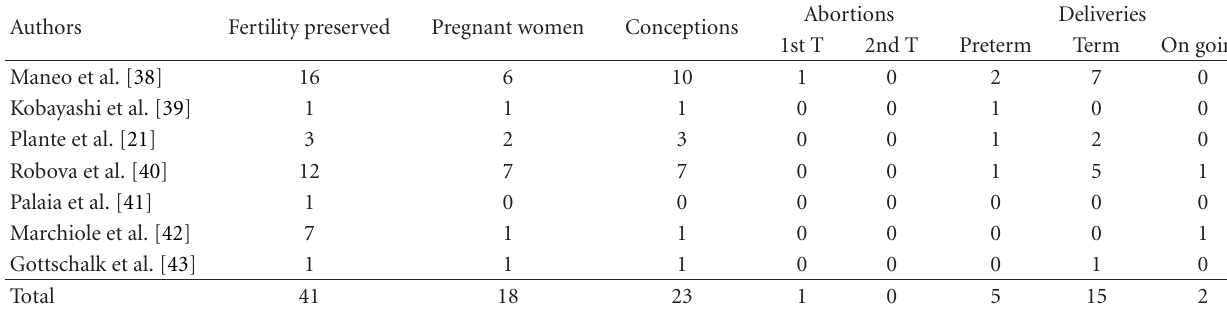
Table 9: Pregnancy outcomes for fertility-sparing surgery after neoadjuvant